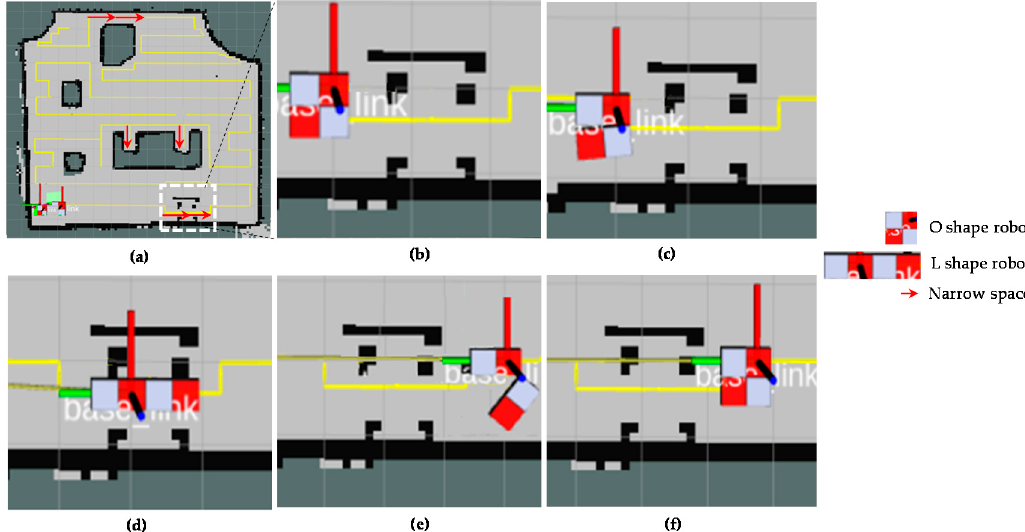
Figure 18. Morphology reconfigurations from O shape to horizontal I shape to navigate through the narrow spaces constraints on RVIZ. ( a ) Detected narrow spaces as red arrows, ( b ) the position before reconfiguring morphology, ( c ) starting morphology reconfiguration, ( d ) navigating with horizontal I shape, ( e ) Morphology reshapes to O after going out of narrow space, ( f ) keep navigating with O shape.